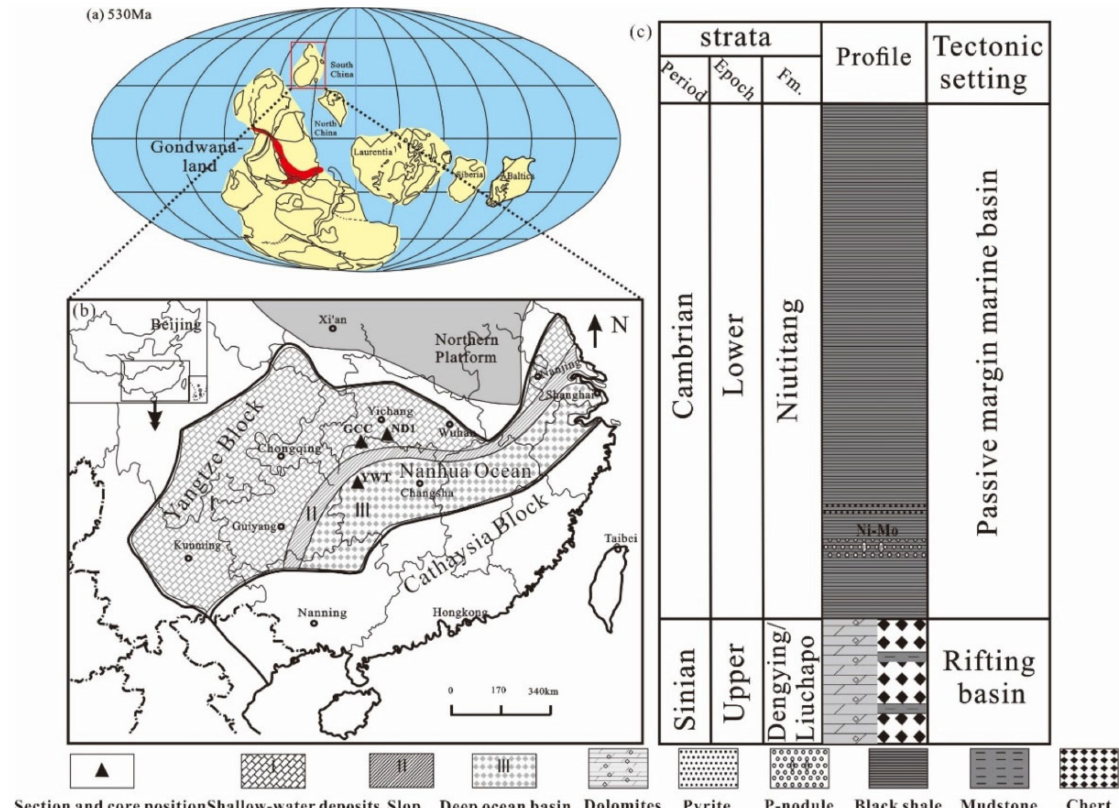
Figure 1. ( a ) Map showing the location of South China in early Cambrian [22]. ( b ) Paleogeographic map of Yangtze Block in Early Cambrian [25,29]. ( c ) Lithologic columns of the lower Cambrian Niutitang Formation in south